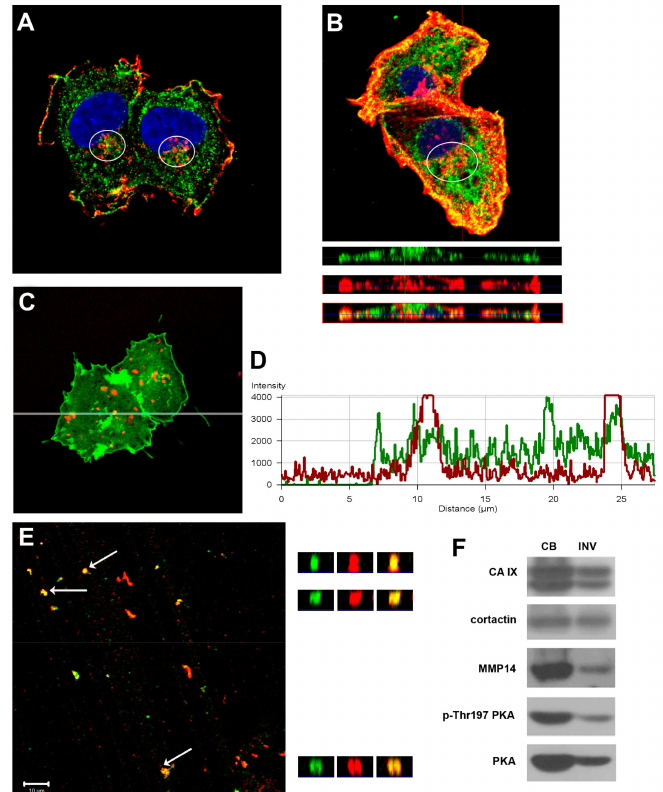
Figure 1. CAIX is present in active invadopodia and colocalizes with invadopodial marker cortactin. ( A ) Immunofluorescent analysis of hypoxia pre-incubated HT1080 cells shows colocalization of CAIX (green) and cortactin (red) in the perinuclear area, marked by a white ellipse, within only 5 h after cells seeding onto a collagen layer. ( B ) CAIX also colocalizes with F-actin (red) in protruding invadopodium as documented by z-stack analysis of cells cultured for 24 h on collagen. ( C ) C33 cells transfected with CAIX-GFP protein were cultured on the Matrigel layer containing DQ-BSA as a marker of proteolytic activity (red). Panel ( D ) shows the intensity profile of CAIX and DQ-BSA signals along the green line denoted in ( C ). Overlapping peaks of green CAIX signal with red peaks indicating spots with proteolytic degradation of the matrix. ( E ) After osmotic lysis of HT1080 cells cultured on gelatin for 48 h in hypoxia the invadopodia entrapped within a gelatin layer were visualized by immunofluorescence (CAIX – green, cortactin - red). The right panels show xz-sections of invadopodia, indicated by white arrows, across the matrix depth. ( F ) Representative Western blot analysis of cell body fraction and isolated invadopodia of HT1080 cells confirms the presence of CAIX in the invadopodial fraction, together with the active form of PKA which phosphorylates